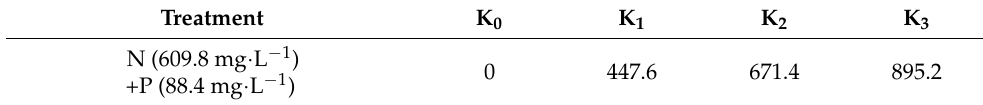
Table 1. Different potassium concentrations applied to the seedlings of L. davidii var. unicolor (mg · L − 1 ). Treatment K